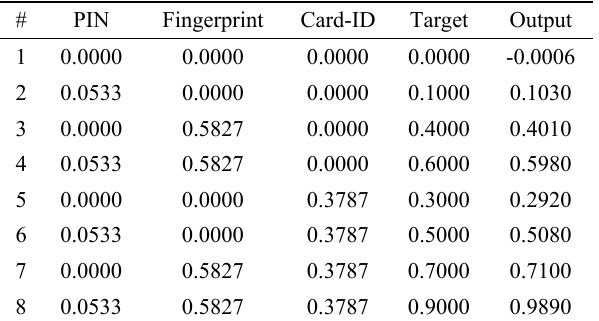
Table 12: Input values, target values and the corresponding output and error values generated by an adaptive neural-fuzzy inference system information fusion technique using entropy identity attributes metrics values.